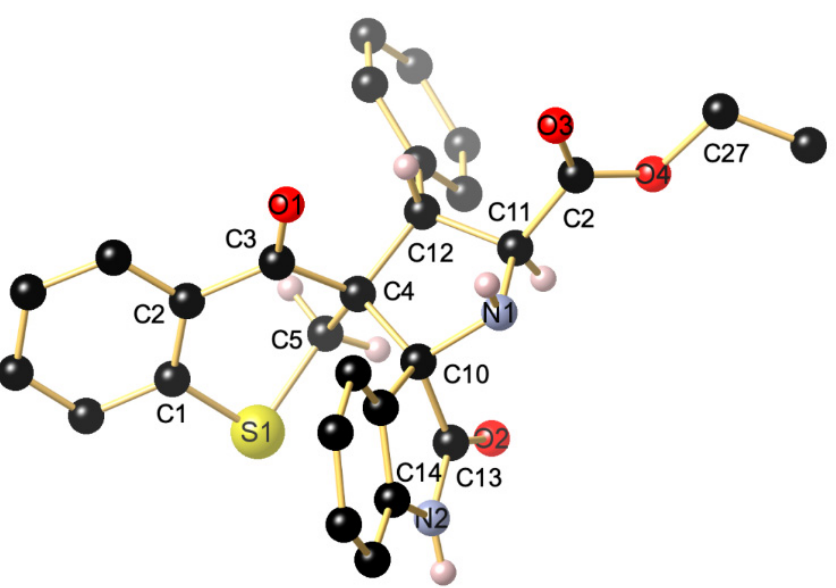
Figure 4. Ball and sticks presentation of the molecular structure of 4a recorded at 100 K. Only one of the two independent molecules is shown. Apart from stereochemically relevant H atoms, all other hydrogen atoms are omitted for clarity. Furthermore, an EtOH molecule of crystallization, present in the asymmetric unit, is not